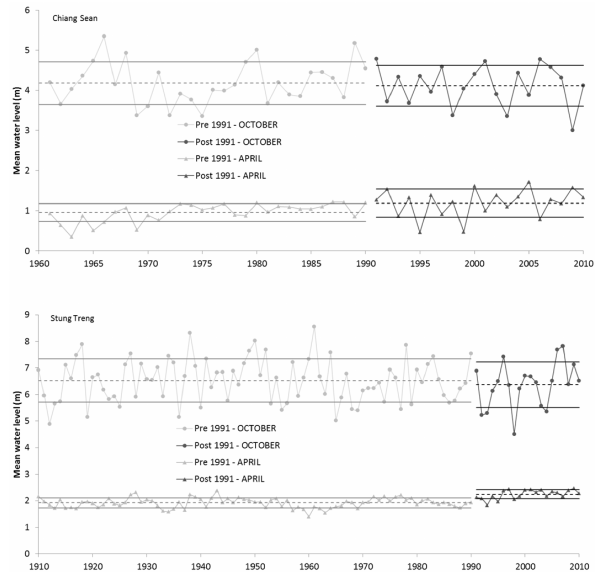
Figure 4. Mean measured water levels at Chiang Saen (1960–2010) and Stung Treng (1910–2010) for the months of April and October. Dashed lines indicate mean water levels for periods before and after 1991 and parallel solid lines indicate ± 1 standard deviations around the mean for each